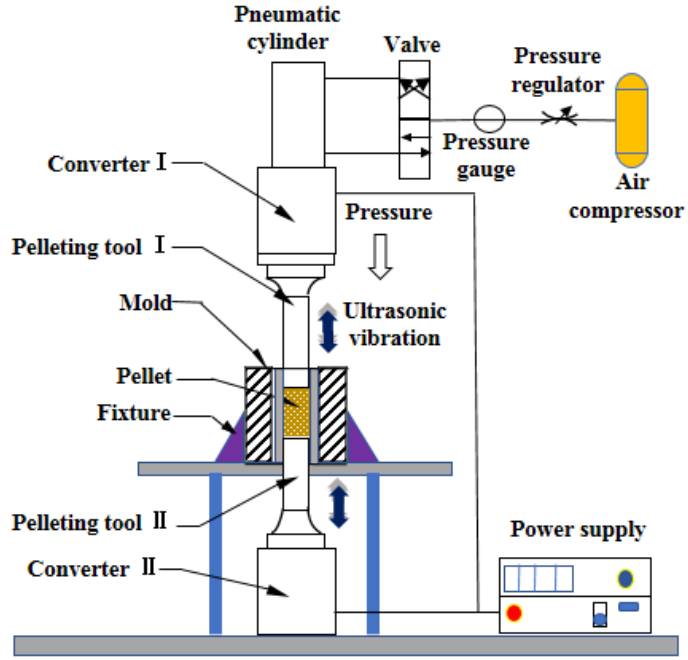
Figure 7. Schematic illustration of the dual ultrasonic pelleting unit.